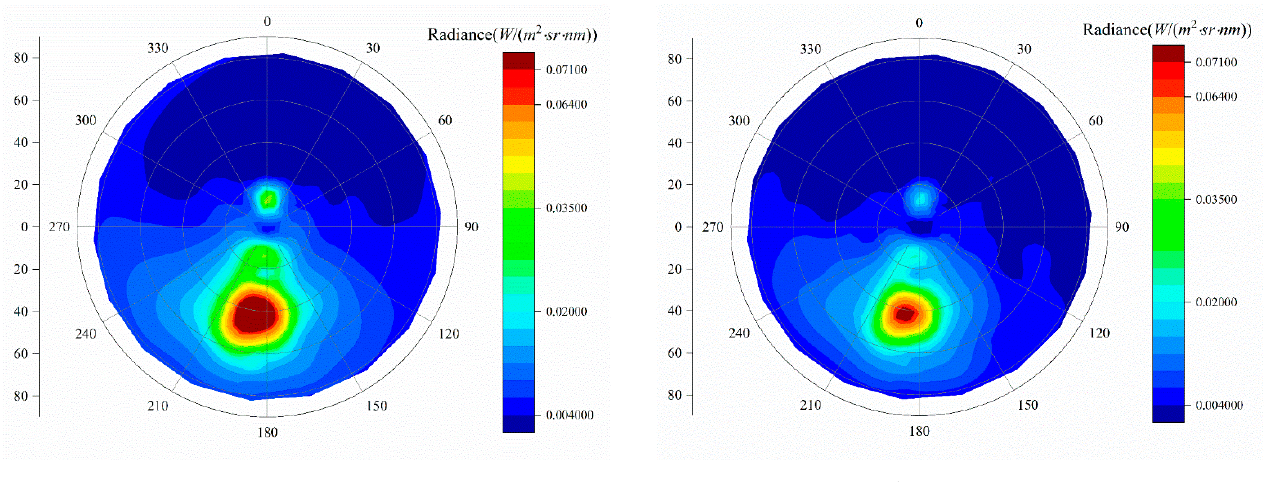
Figure 16. Two images of sky radiation distribution at single wavelength.